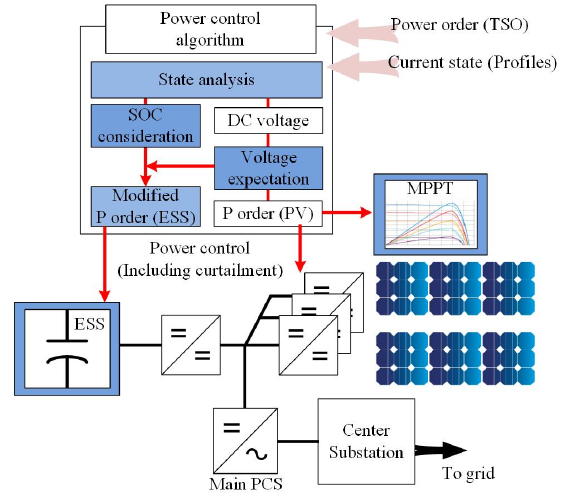
Figure 2. Power control concept of ESS-combined PV system.